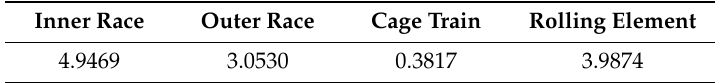
Table 2. Fan-end bearing defect frequencies (multiples of the running speed in Hz).